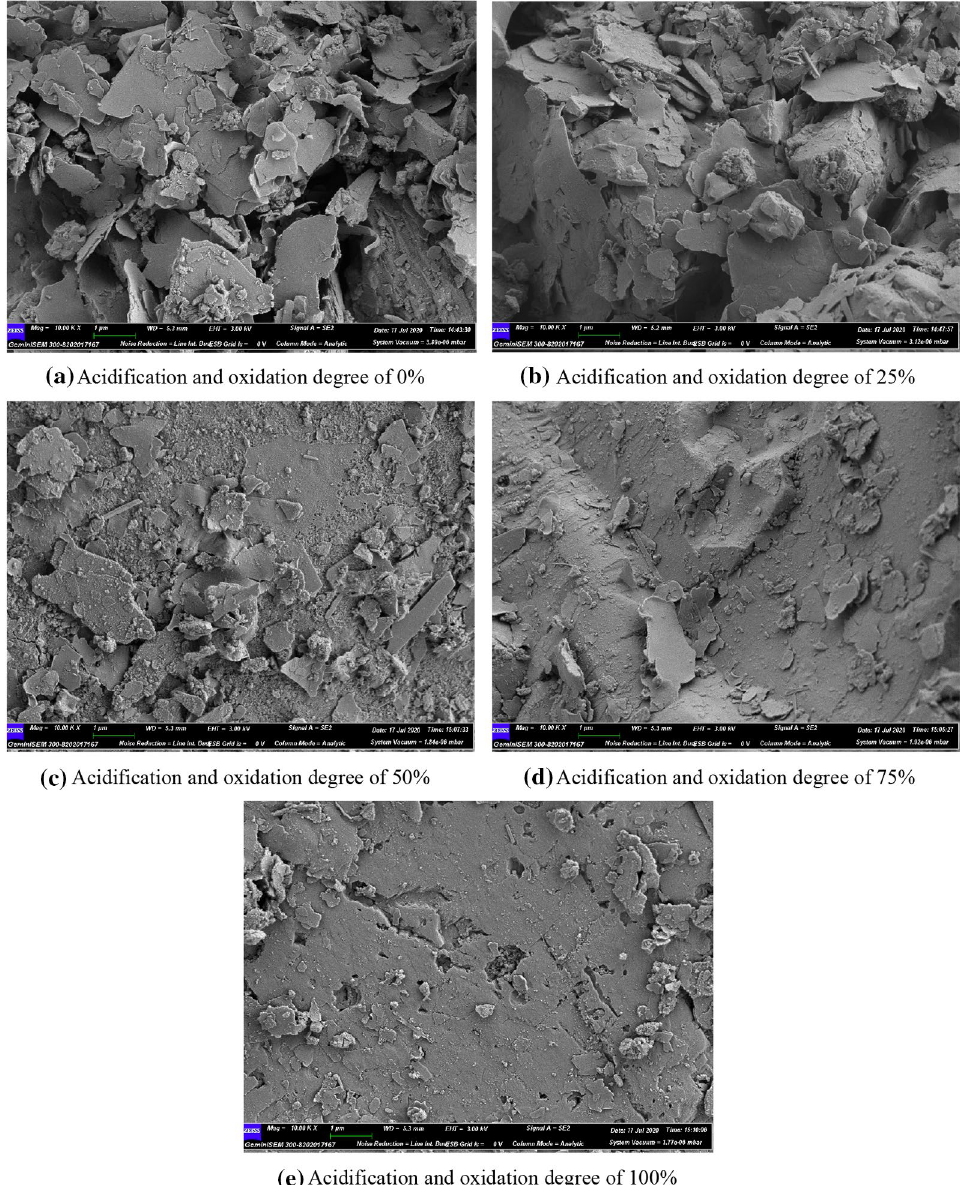
Figure 2. SEM photos of tailings sand under different oxidation and acidification